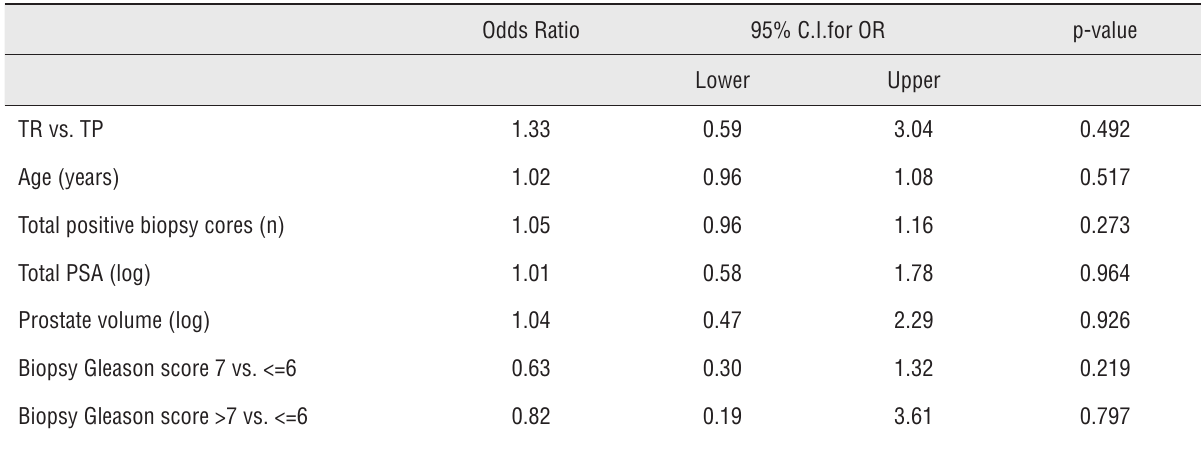
Table 3 - Multivariate